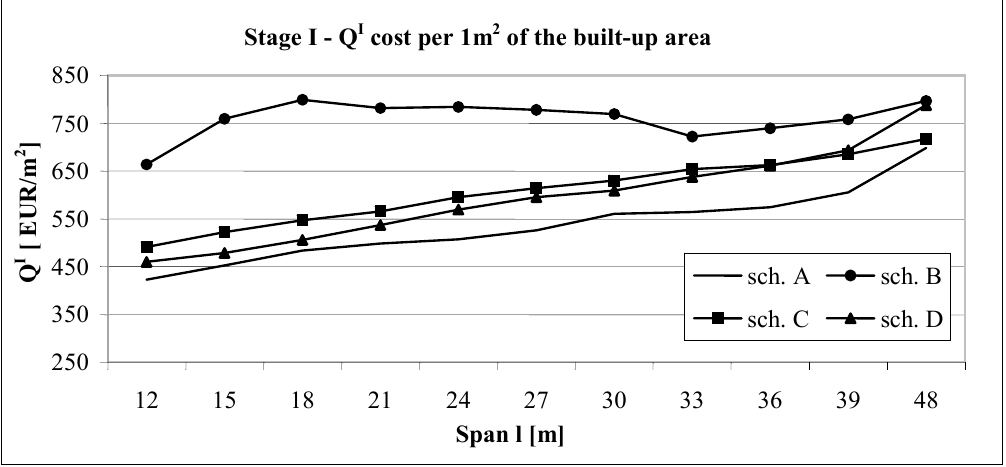
Figure 3. Cumulative Q I cost per 1 m 2 of the built-up area.